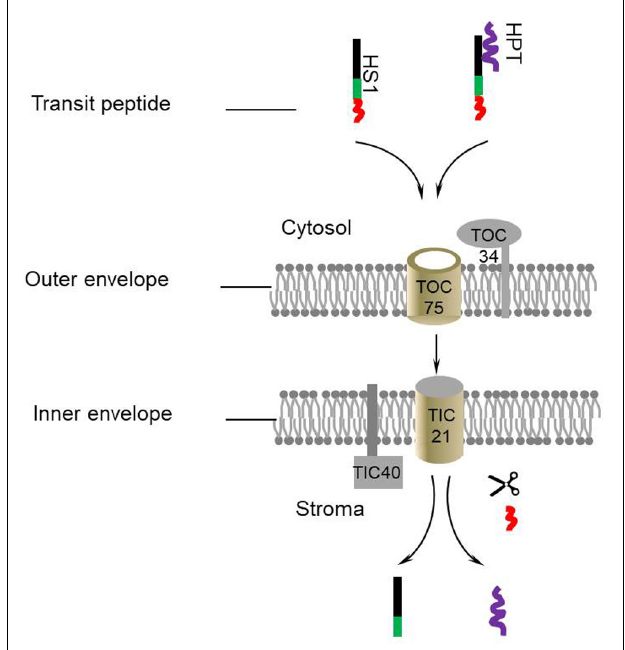
FIGURE 5 | A proposed model for HS1-mediated chloroplast transport of HPT. HS1 directly interacts with HPT and guides the protein to the TOC/TIC complex. Subsequently they are transported into the chloroplast. The transit peptide of HS1 is removed by a stromal processing protease and transit HPT are